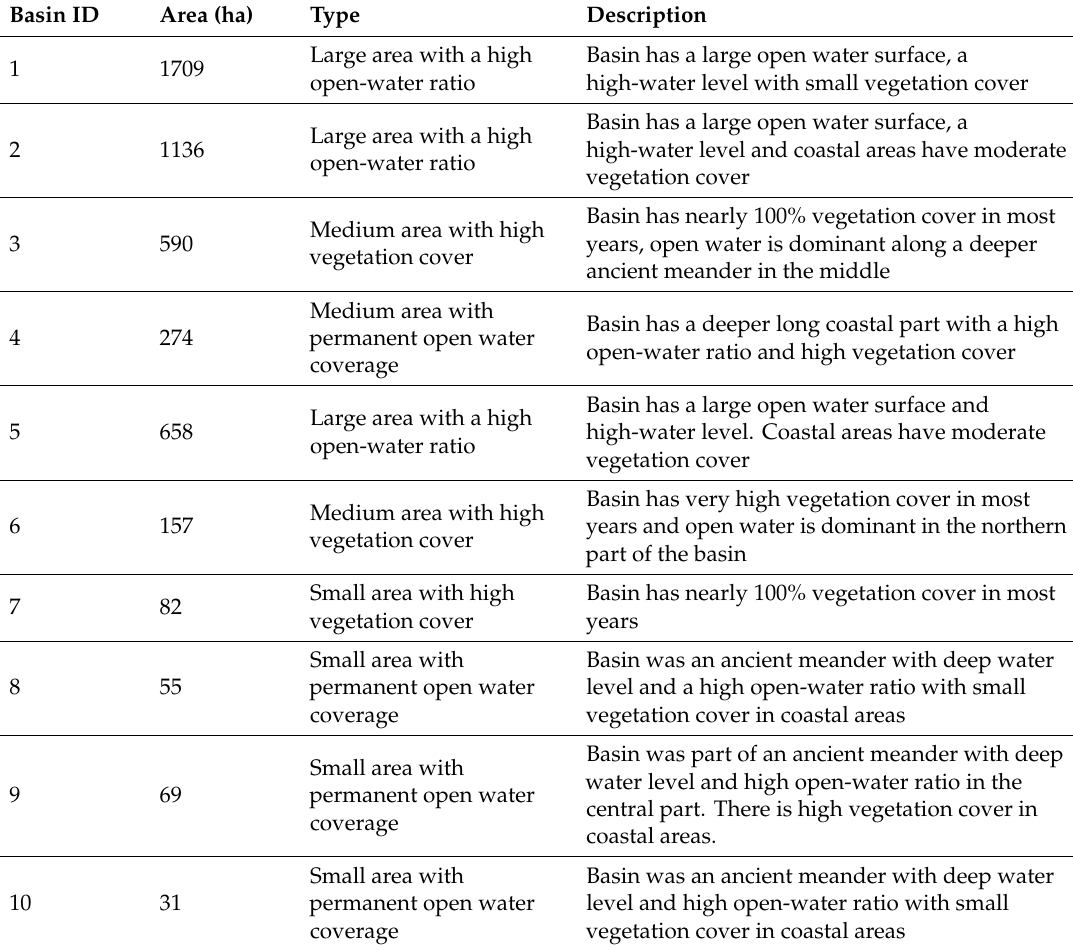
Table 1. Basin types and